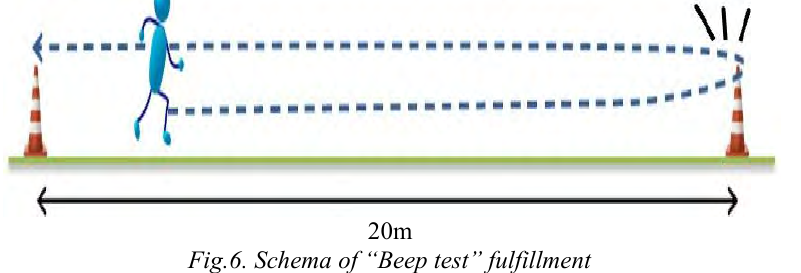
Fig.6. Schema of “Beep test” fulfillment